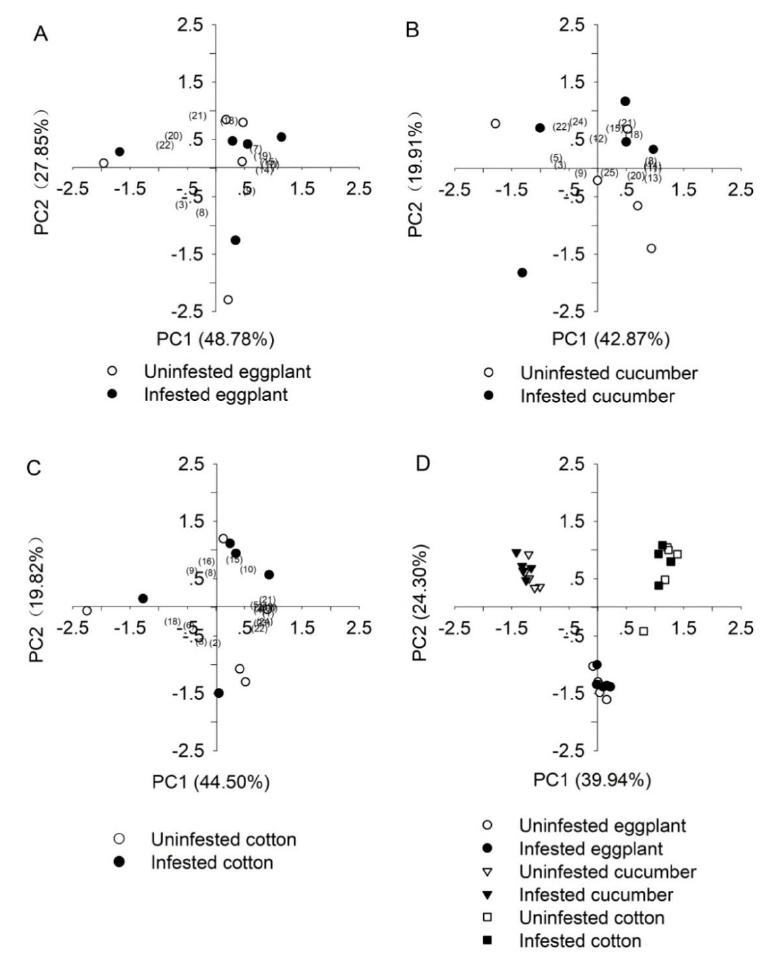
Figure 6. Principal component analysis (PCA) of volatile compounds from uninfested and Bemisia tabaci -infested host plant species. PCA with a factor loading plot was used to analyze single plant species, including eggplant ( A ), cucumber ( B ) and cotton ( C ). ( D ) PCA for three plant species, namely eggplant (circles), cucumber (triangles) and cotton (diamonds) based on the 25 identified volatile components. Score plots of PC1 and PC2 with the percentage of total variance explained by each axis are shown. Each point represents an individual plant. Compound numbers in Figure 6 correspond with compound numbers in Table